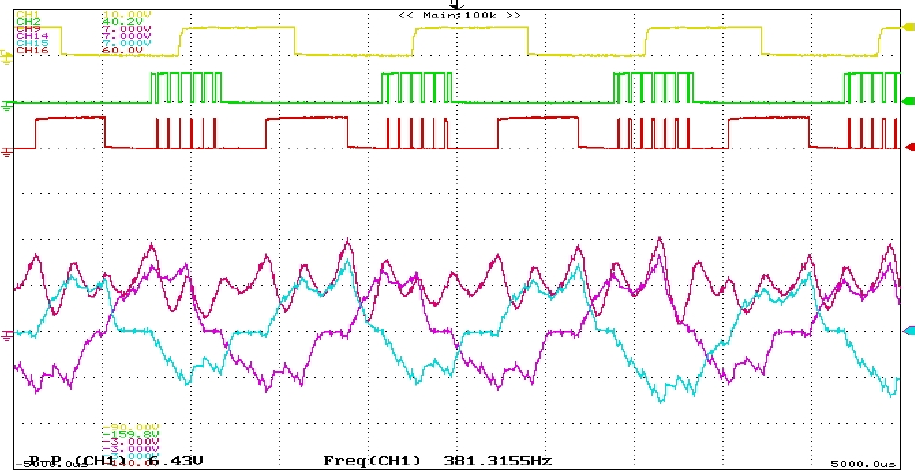
Figure 16. Phase currents, and DC bus currents are aligning with respective Hall, PWM signal Vs time.